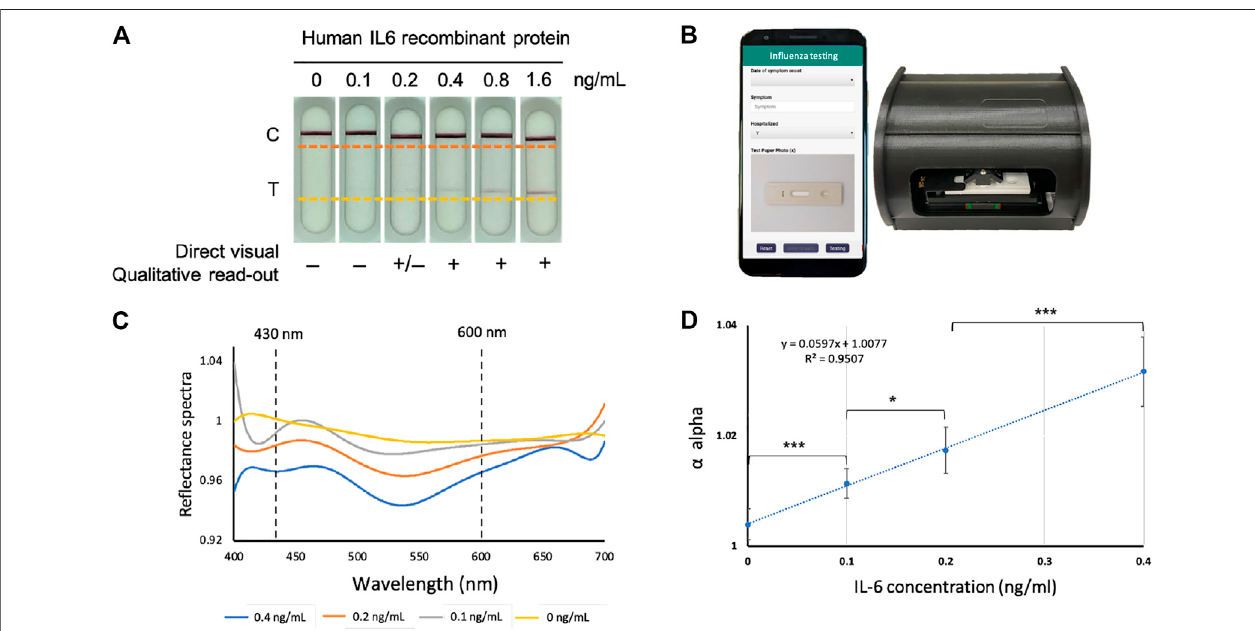
FIGURE 1 | The IL-6 paper-based test strip and spectrum-based optical reader. (A) The IL-6 test strips loaded with pre-determined amounts of puri fi ed IL-6 protein. (B) Spectrum-based optical reader and mobile-phone which could connect to the reader (in collaboration with SpectroChip Inc., Taiwan; Taiwan FDA: MD (I)-008090andU.S.FDA:3017810861). (C) There fl ectancespectraofthepredeterminedamountsofpuri fi edIL-6proteininstandardscale. (D) Linearregressionfor the α value of IL-6 protein at concentrations of 0, 0.1, 0.2, 0.4 pg/ml to determine the limit of detection (LOD) and limit of quanti fi cation (LOQ), Y -axis; α value, X -axis; IL-6 concentration based on test strip coupled with optical reader, * p < 0.05, *** p < 0.001.